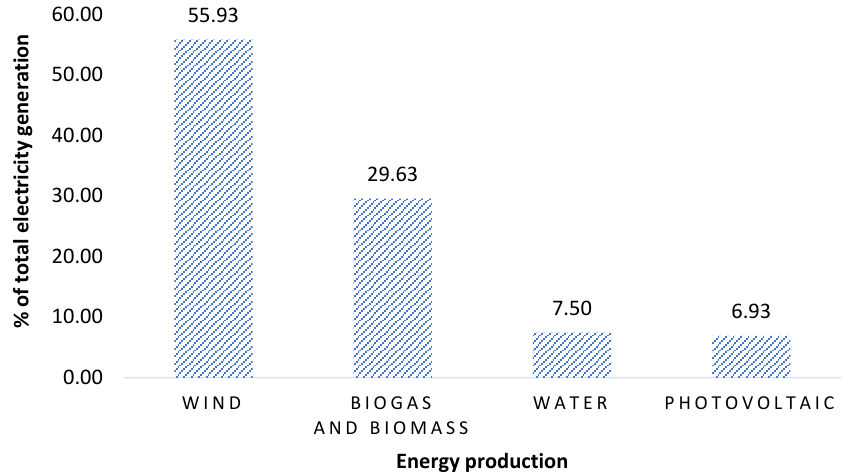
Figure 2. Electricity generation by RES in 2020, GWh [7].